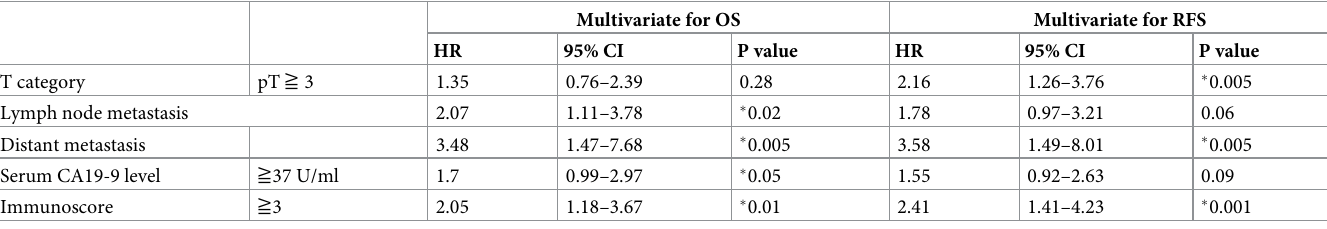
Multivariate for